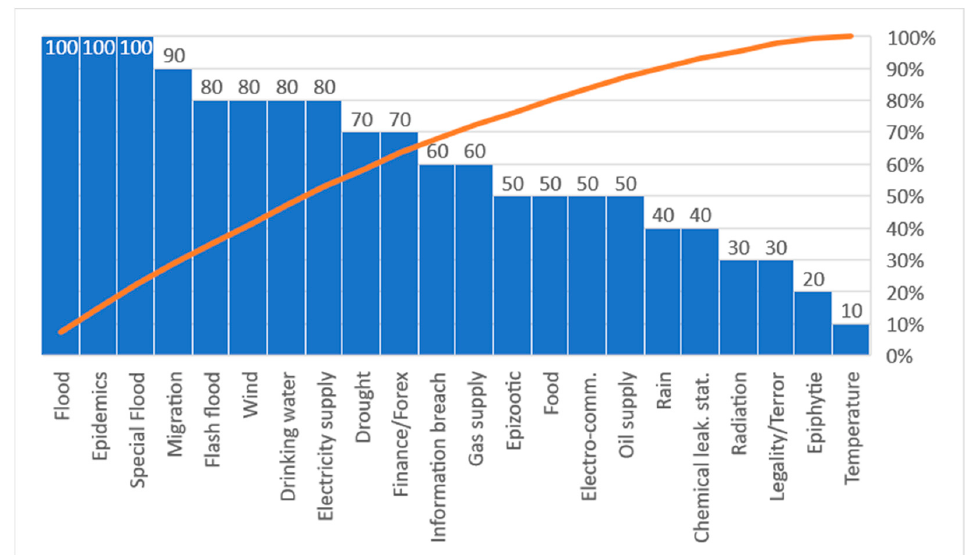
Figure 8. Pareto diagram of processed inputs by region.